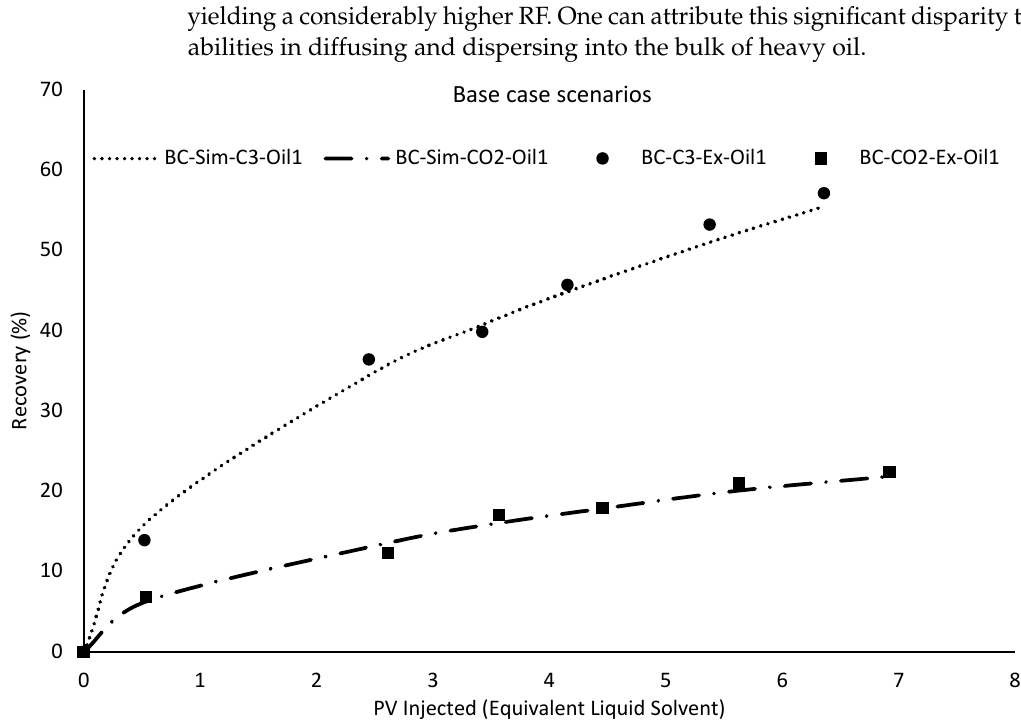
Figure 9. The base case scenario results for propane and carbon dioxide injection.